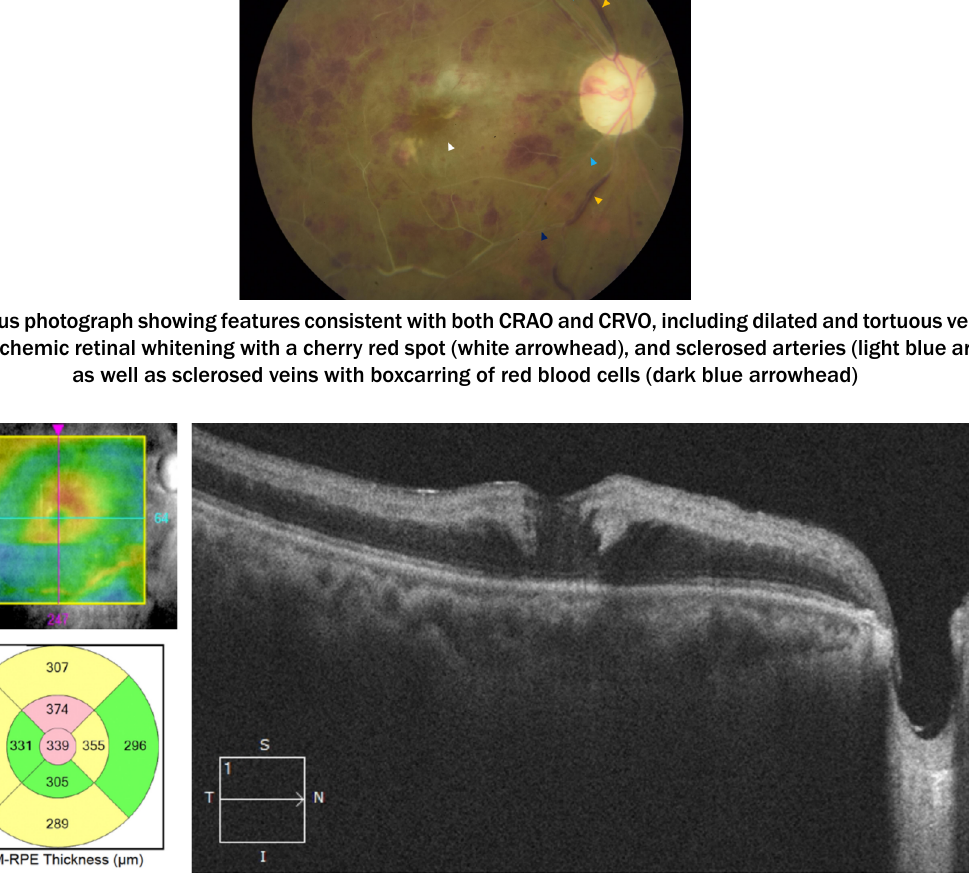
Figure 4: Optical coherence tomography scan showing hyperreflective and thickened inner retinal layers that correspond to retinal edema as well as mild cystoid changes in the fovea